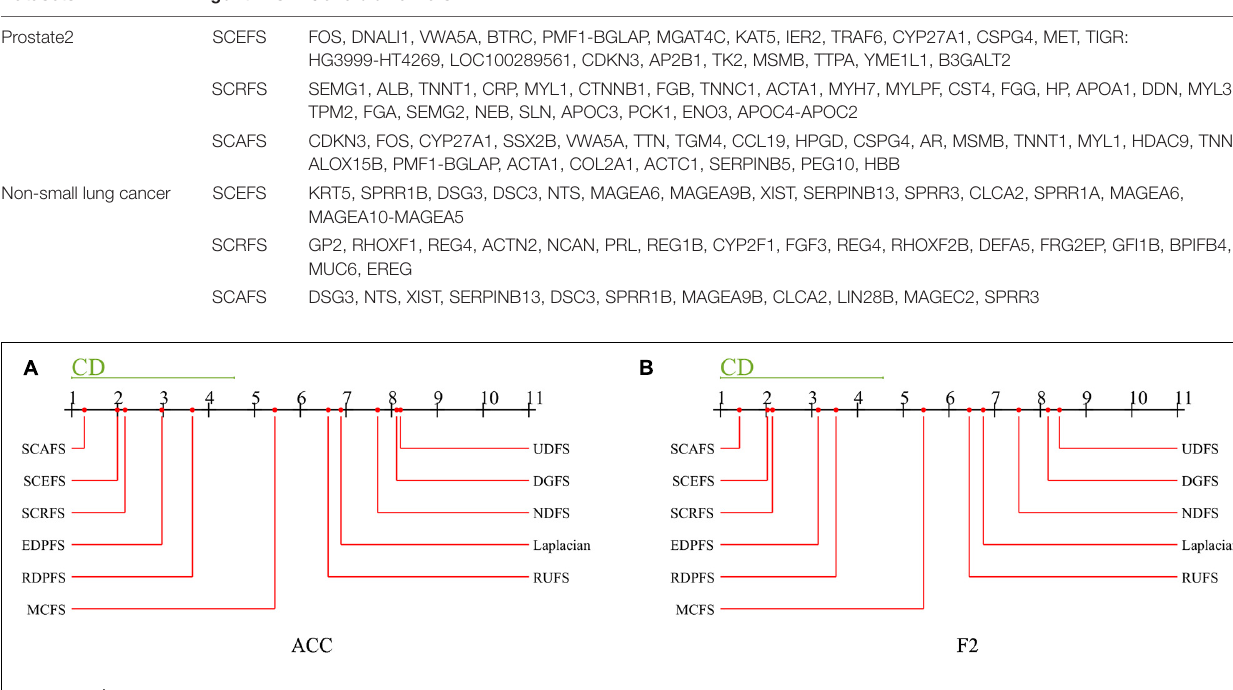
TABLE 7 | The gene biomarkers of Prostate2 and Non-small lung cancer selected by our algorithms. Datasets